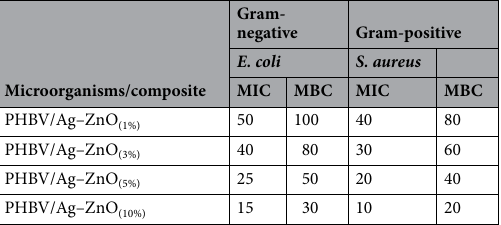
Table 1. Antimicrobial properties of synthesized PHBV/Ag–ZnO (1, 3, 5, 10%)